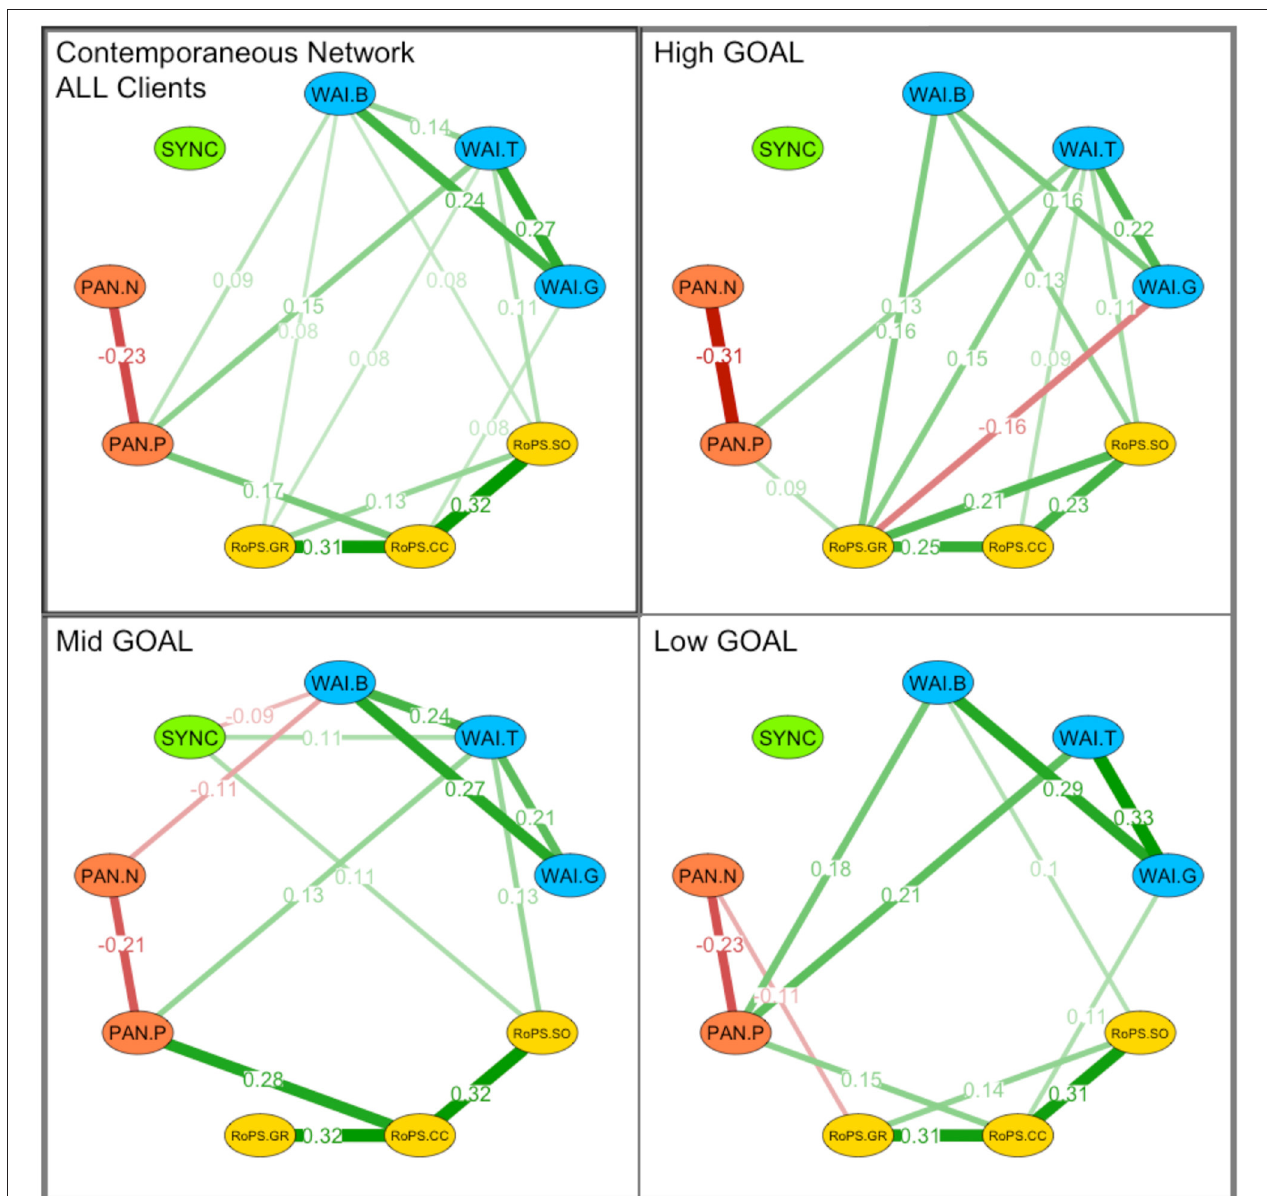
FIGURE 10 | Contamporaneous network analysis by goal groups. Network analyses: Contamporaneous associations between synchrony (SYNC), working alliance (WAI), affective experience (PAN), and cognitive self-regulation (RoPS). Associations highlight nodes between the following variables: WAI.B, Working Alliance Bond; WAI.T, Working Alliance Task Setting; WAI.G, Working Alliance Goal Orientation; RoPS.SO, Result-oriented Problem and Self-Reflection.Self-Organization; RoPS.CC, Result-oriented Problem and Self-Reflection.Concrete Changes; RoPS:SO, Result-oriented Problem and Self-Reflection.Self-Organization; PAN.P, PANAS Positive Affect; PAN.N, PANAS Negative Affect; Associations are clustered by “ALL Clients” as well as groups of High GOAL attainment, Mid Goal attainment, and Low Goal attainment.